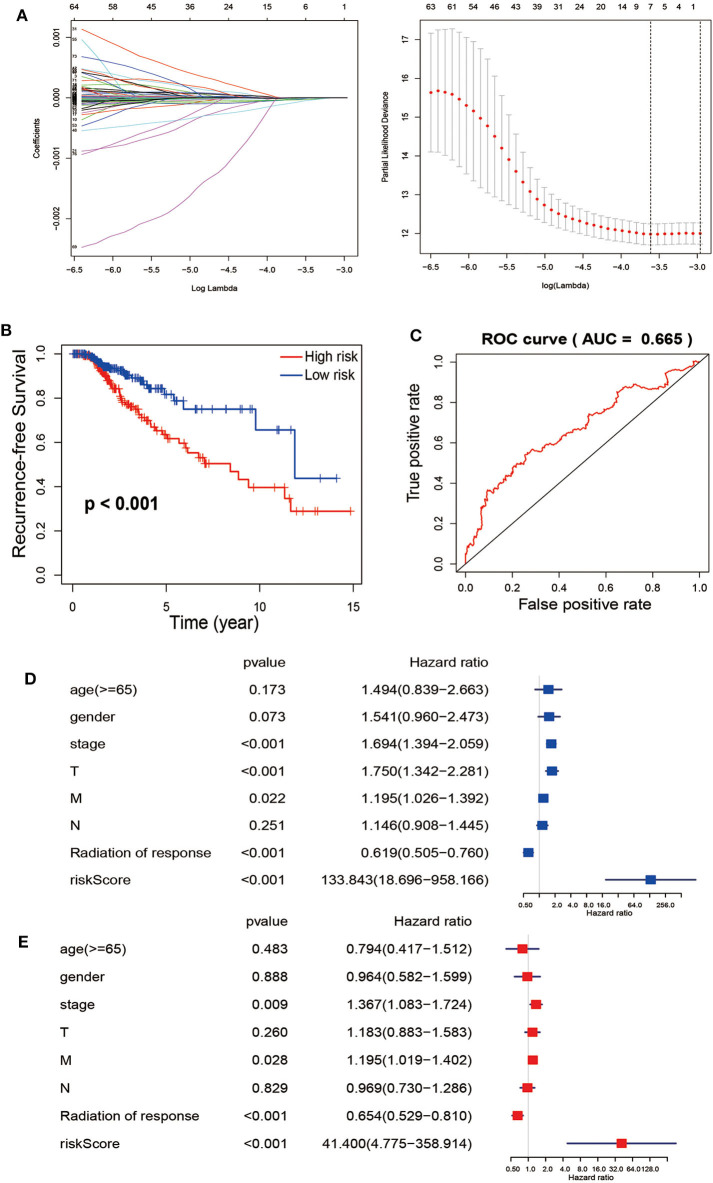
The Cox regression analysis for estimating the clinical value of the risk score. (A) For construction of a signature from TCGA-TCHA cohort, Twelve-fold cross-validation, where optimal λ lead to 24 non-zero coefficients, is applied for selecting tuning parameters in the LASSO model. The best values by minimum- (lambda.min, left vertical dotted line) and 1-SE- criteria (lambda.1se, right vertical dotted line) representing the dotted vertical lines. Partial LASSO coefficient profiles of the 77 mRNAs. (B) Recurrence-free survival between patients with high risk (red) and low-risk (blue). (C) Calculate the area under the ROC curve for risk score. The univariate (D) and multivariate (E) Cox regression analysis of age, gender, grade, TNM stage, radiation of response and risk score, age, gender, pathological stage, and TNM stage of the whole survival risk score according to the ROC curve.